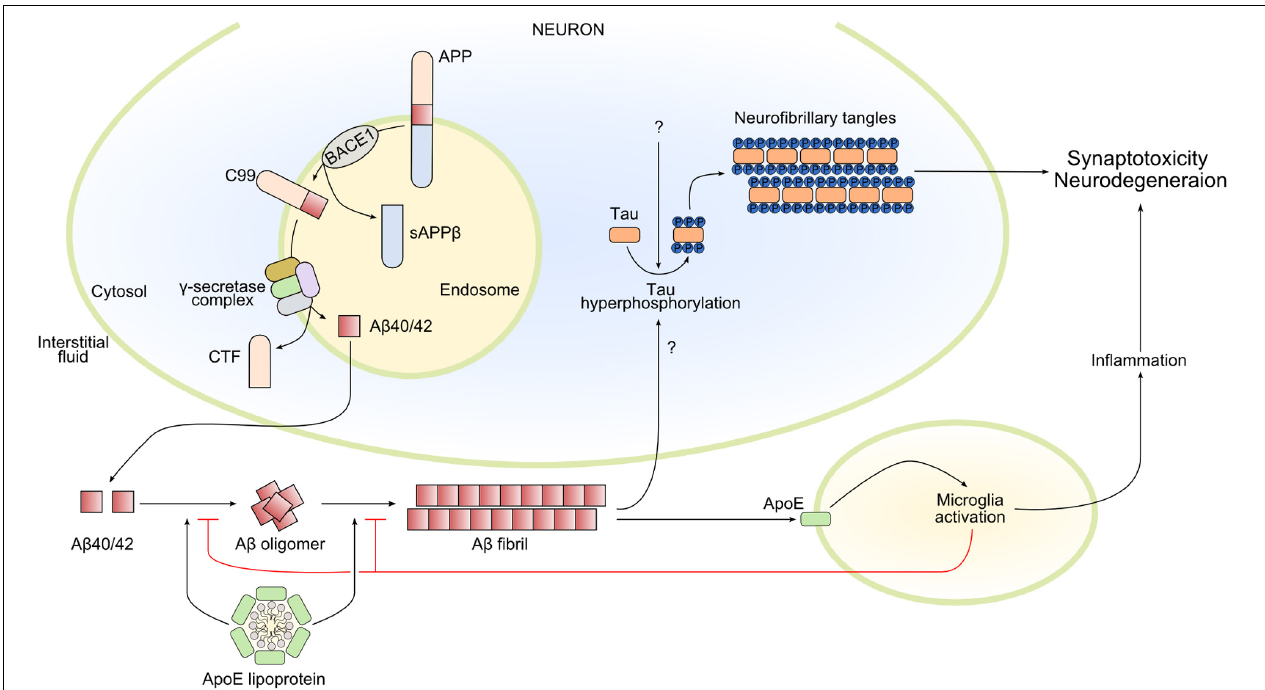
FIGURE 2 | Main pathways involved in Alzheimer’s disease pathophysiology. Amyloid- β 40/42 (A β 40 / 42 ) is produced by the sequential cleavage of amyloid precursor protein (APP) by BACE1 ( β -secretase 1) and γ -secretase complex in the endosome. After secretion into the interstitial fluid, A β 40 / 42 forms oligomers and A β fibrils that contribute in different ways to Alzheimer’s disease pathology. In particular, A β fibrils activate the hyperphosphorylation of tau, promoting its oligomerization and the formation of intracellular neurofibrillary tangles, leading to synaptotoxicity and neurodegeneration. Amyloid- β fibrils also activate microglia by apolipoprotein E (ApoE)–dependent mechanisms. Microglia activation can have both beneficial and damaging effects: microglia reduce and delay A β fibril formation, but the prolonged release of inflammatory mediators could lead to neurodegeneration. Finally, ApoE lipoprotein also modulates A β oligomerization and A β fibrils. CTF, C-terminal fragment; sAPP β , soluble APP β ; C99, the 99-amino acid C-terminal domain of APP.